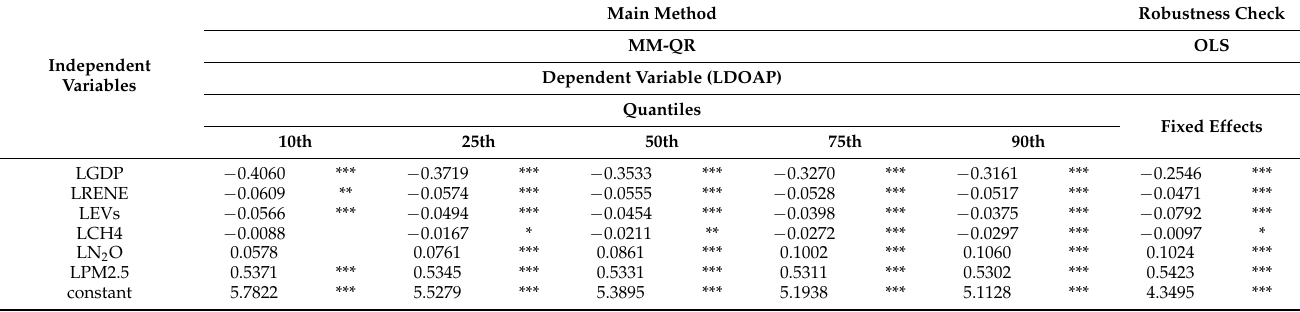
Table 10. Estimation results from the MM-QR regression model and OLS with fixed